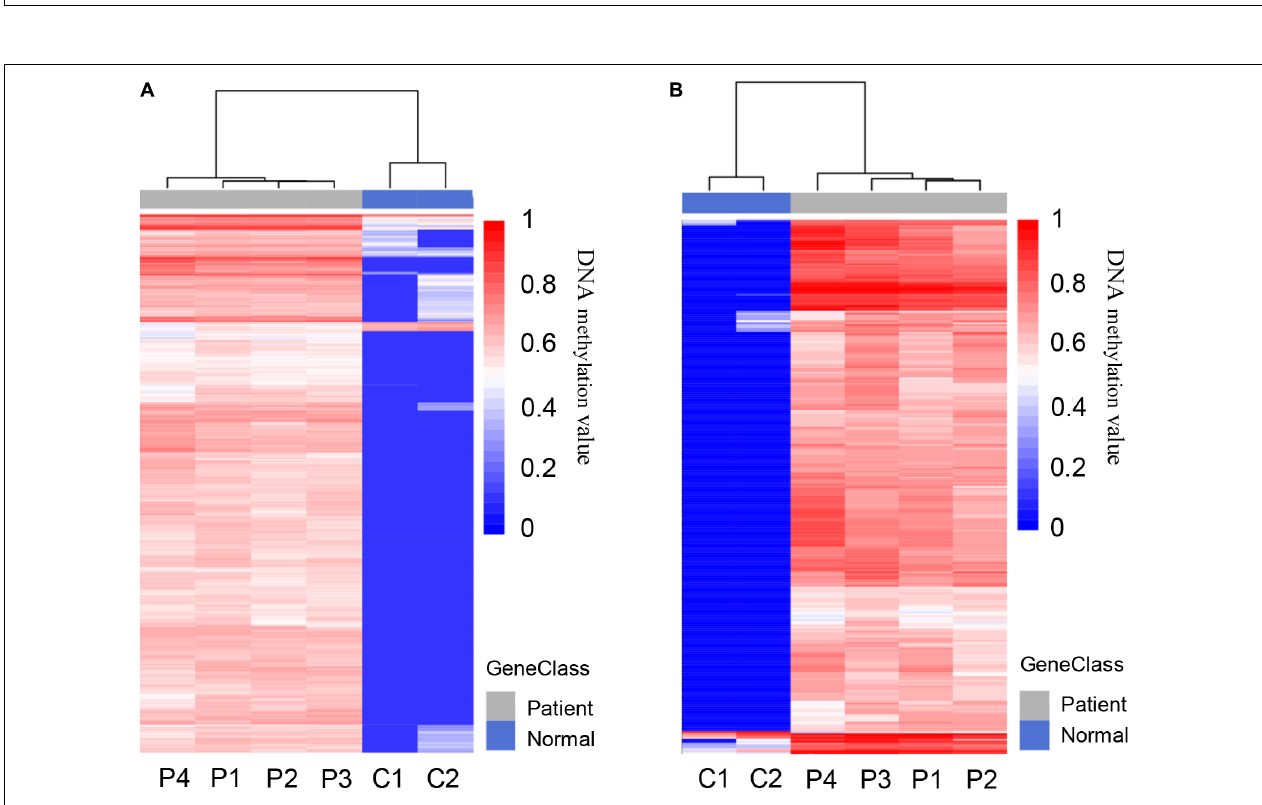
FIGURE 3 | Differentially methylated regions (DMRs) in pancreatic cancer patients and healthy controls. (A) Heat map of total 5,205 DMRs located in the whole genome of PDAC patients compared to healthy controls, including 5,117 hypermethylated and 88 hypomethylated regions. (B) Heat map of total 775 DMRs located in the promoter regions of patients compared to healthy controls, including 761 hypermethylated and 14 hypomethylated regions.